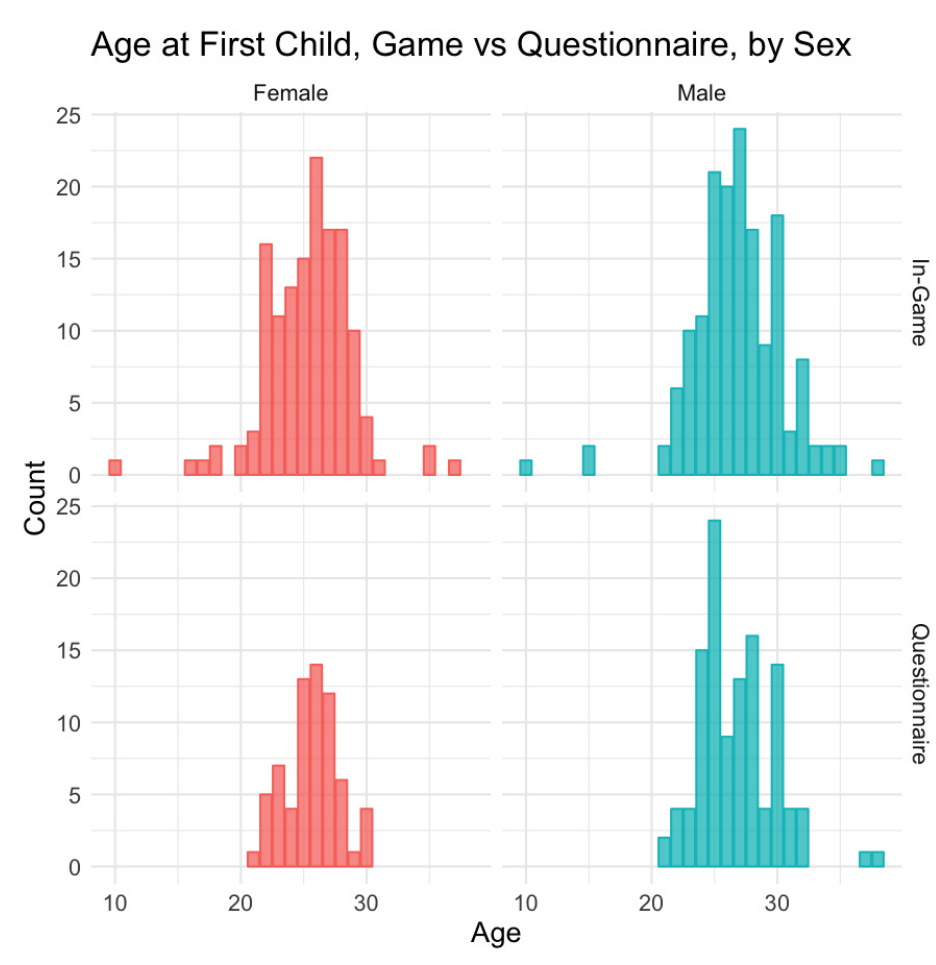
Figure 9. Distribution of desired age at first child within game compared to in post-game